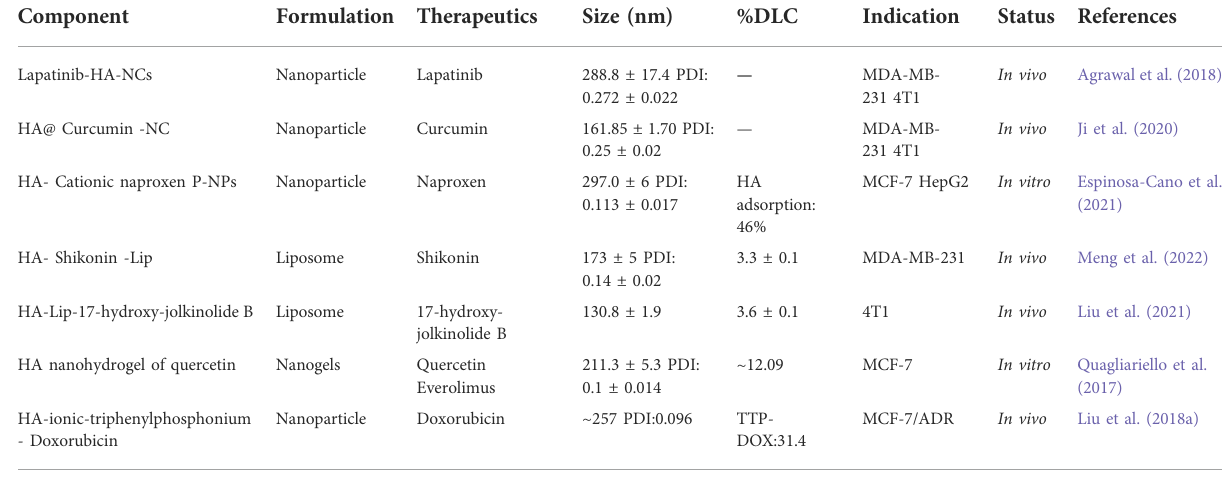
TABLE 1 Characteristics of HA